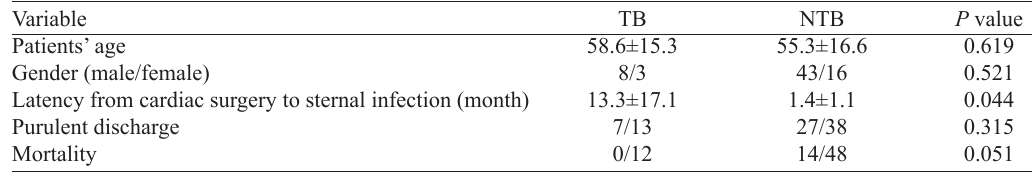
Table 2. A comparison between tuberculous and non-tuberculous mycobacterial sternal infections. Variable Patients’ age Gender